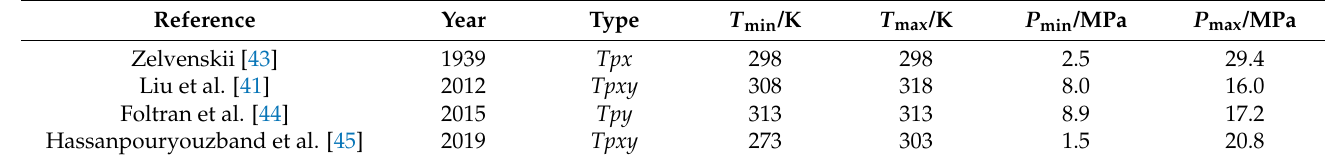
Table 2. Literature phase behaviour data of (CO 2 + H 2 O + N 2 ) ternary